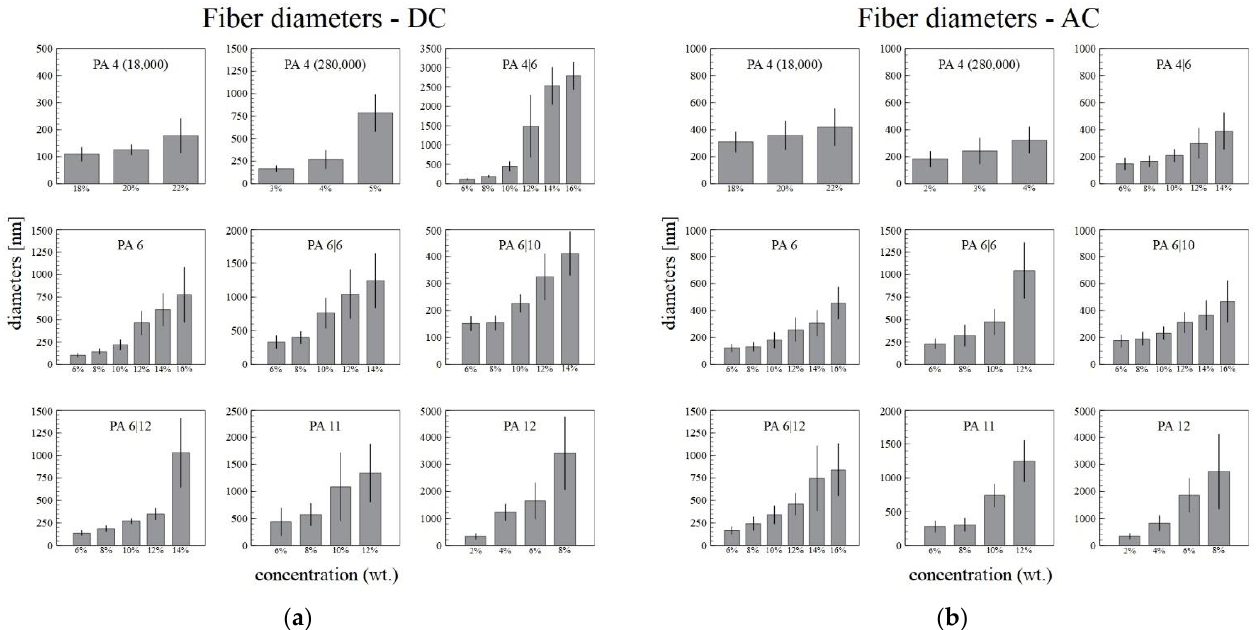
Figure 4. The dependence of the DC ( a ) and AC ( b ) electrospun fiber and ribbon diameters on the concentration of the solution, with the corresponding standard deviations.